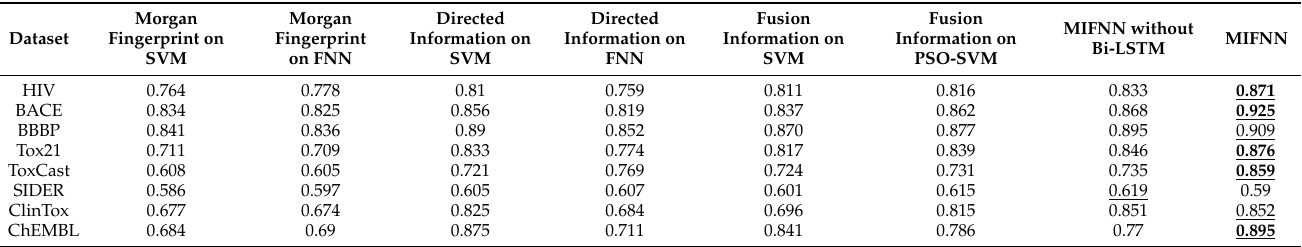
Table 3. Comparison of AUC values for various models. (underlined values are maximum values; bolded values are significantly higher than those of other